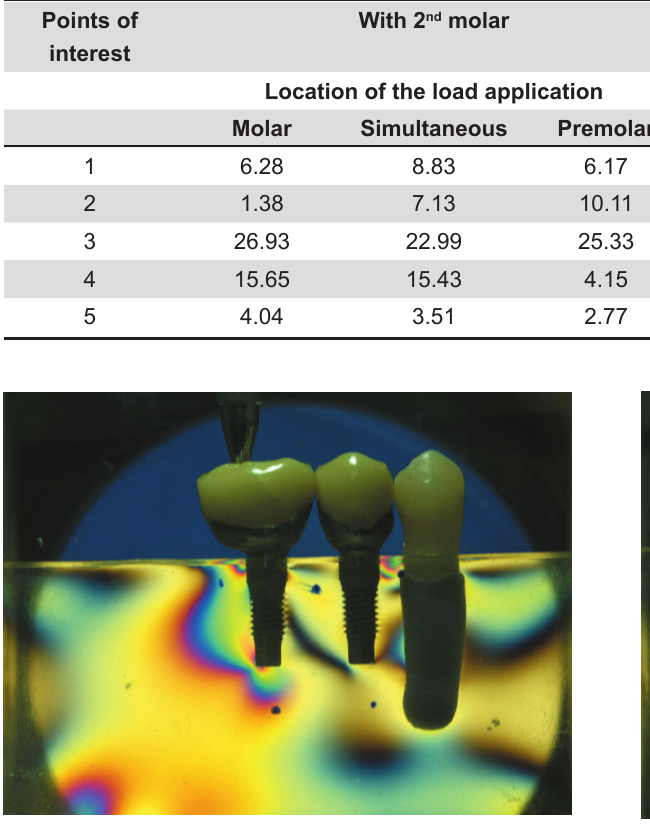
Figure 3- Vertical single point load (5 kgf) on the first molar (model without the second molar replica)